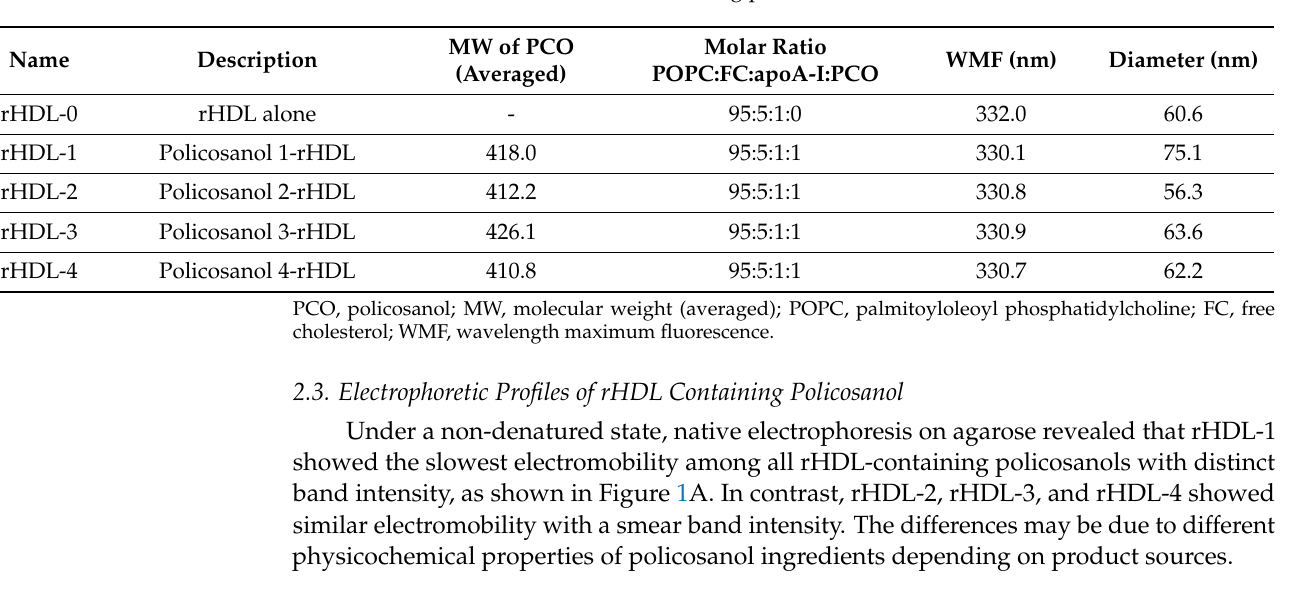
Table 2. Characterization of rHDL containing policosanol from different sources.